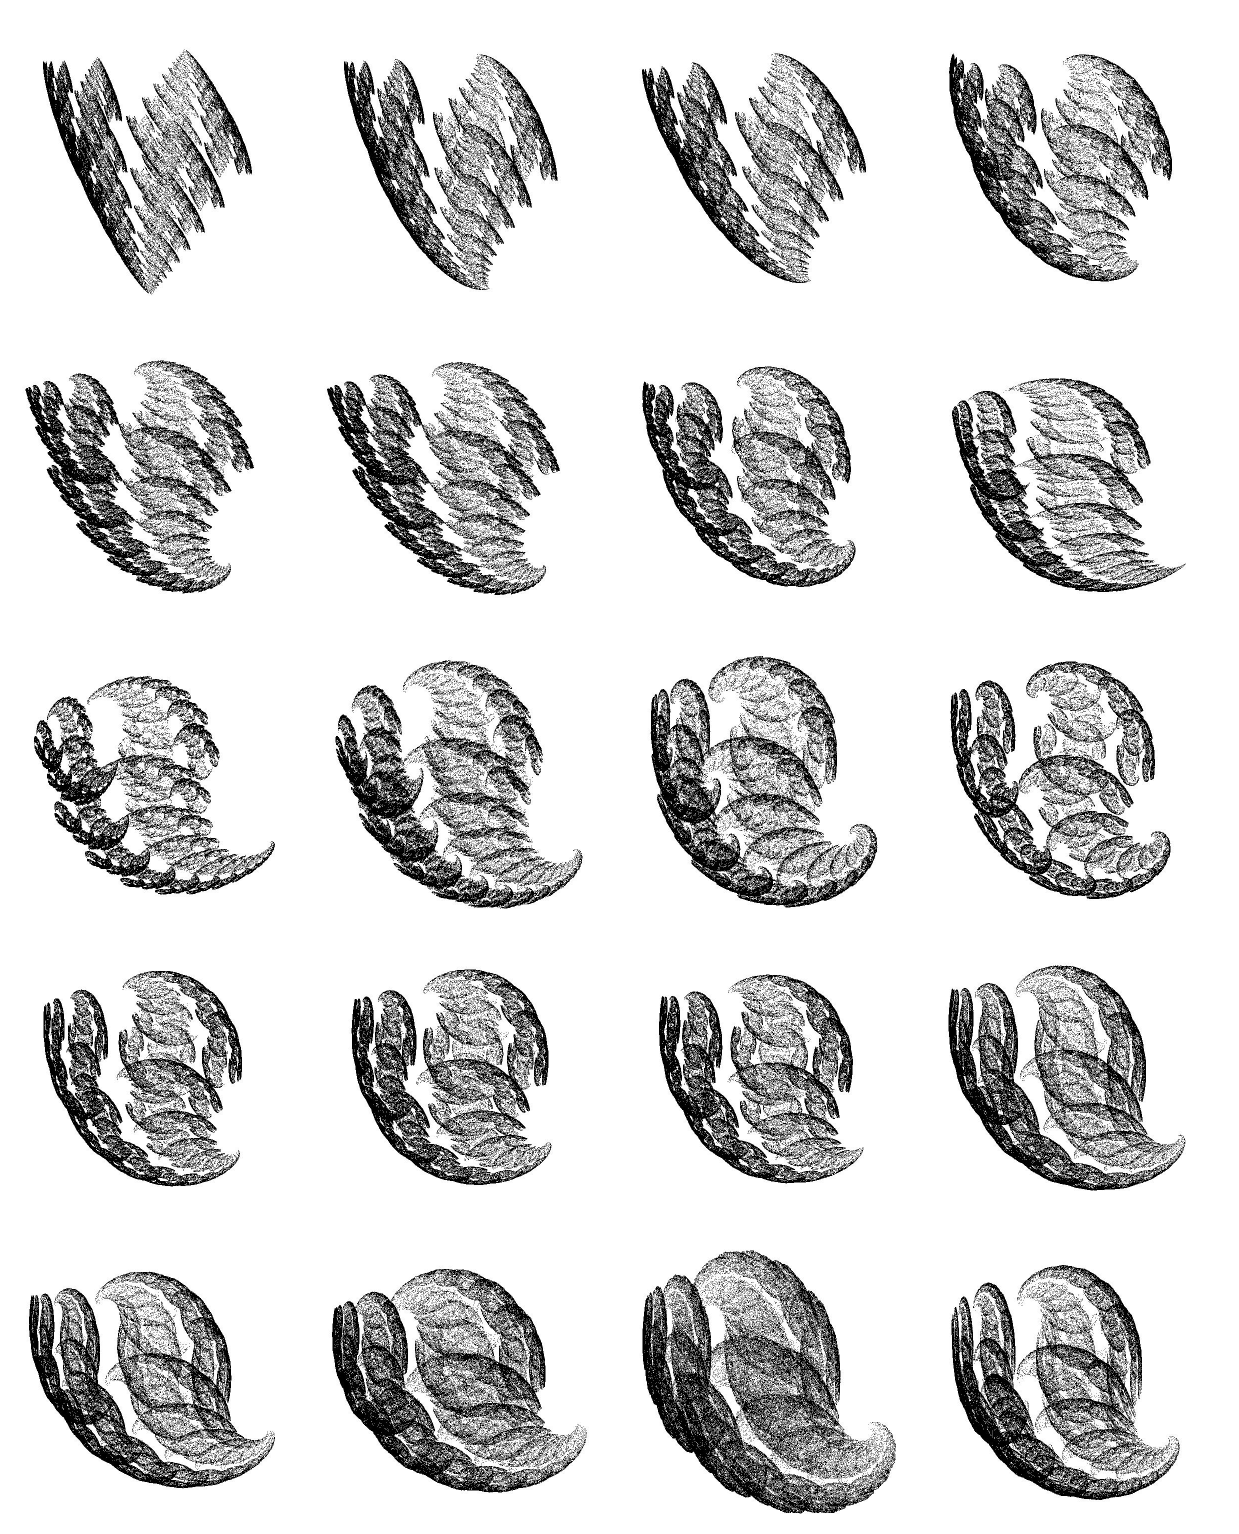
Figure 5. ( left – right , top – bottom ): Evolution of the reconstructed image for 400–780 iterations (step size, 20